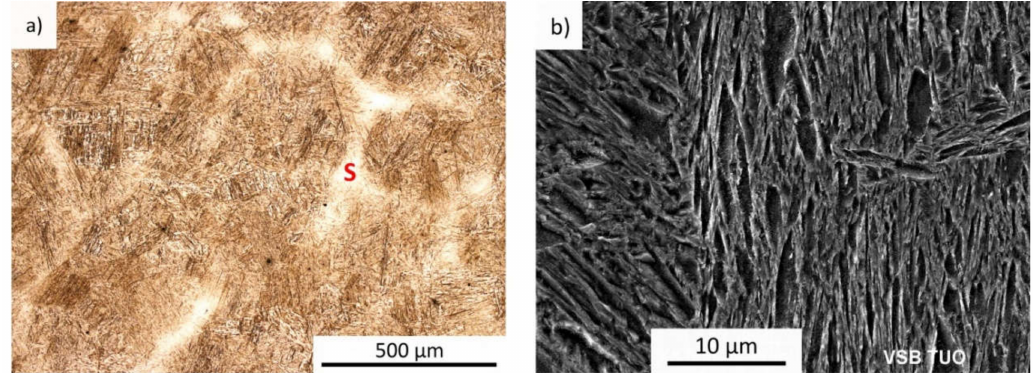
Figure 8. Microstructure of the sample quenched from a heating temperature of 1140 ◦ C. ( a ) Light microscopy—segregations in bright areas, marked S; ( b ) SEM—close-up view of lath